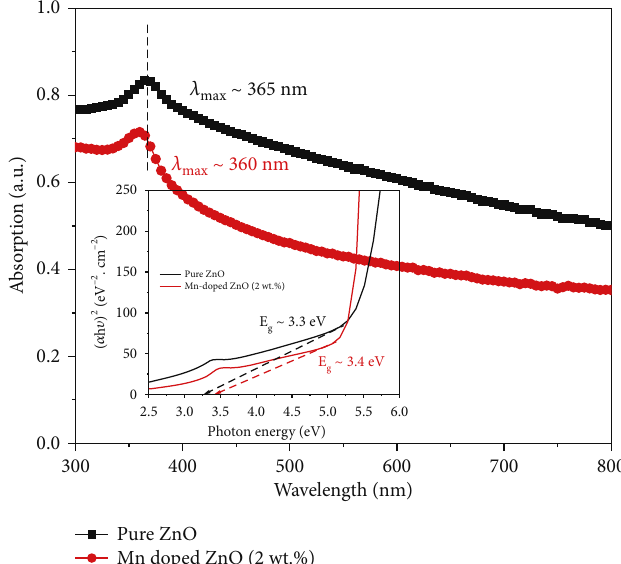
Figure 5: The UV-vis absorption spectra of pure and Mn-doped ZnO nanoparticles and (inset) the bandgap estimation of synthesized samples via Tauc plot.